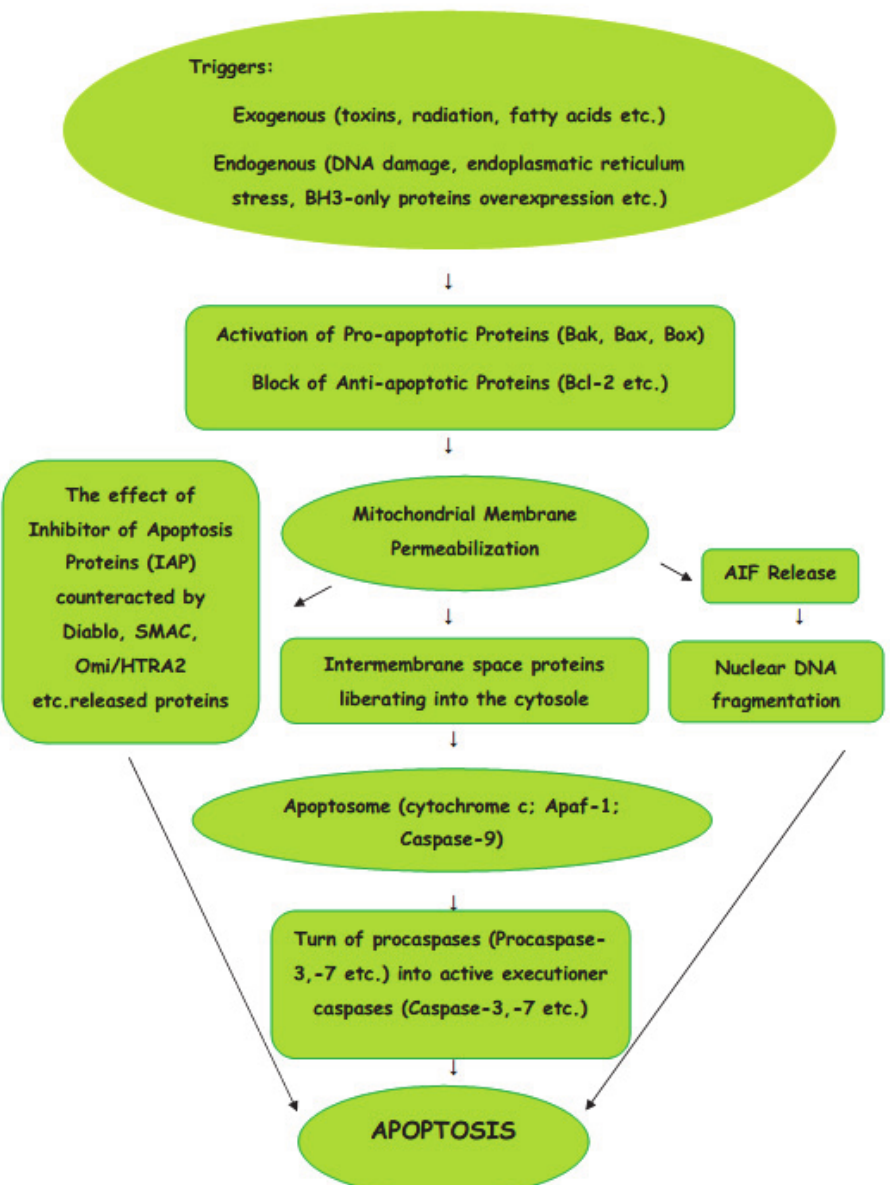
Figure 1. Intrinsic (mitochondrial) pathway of apoptosis.